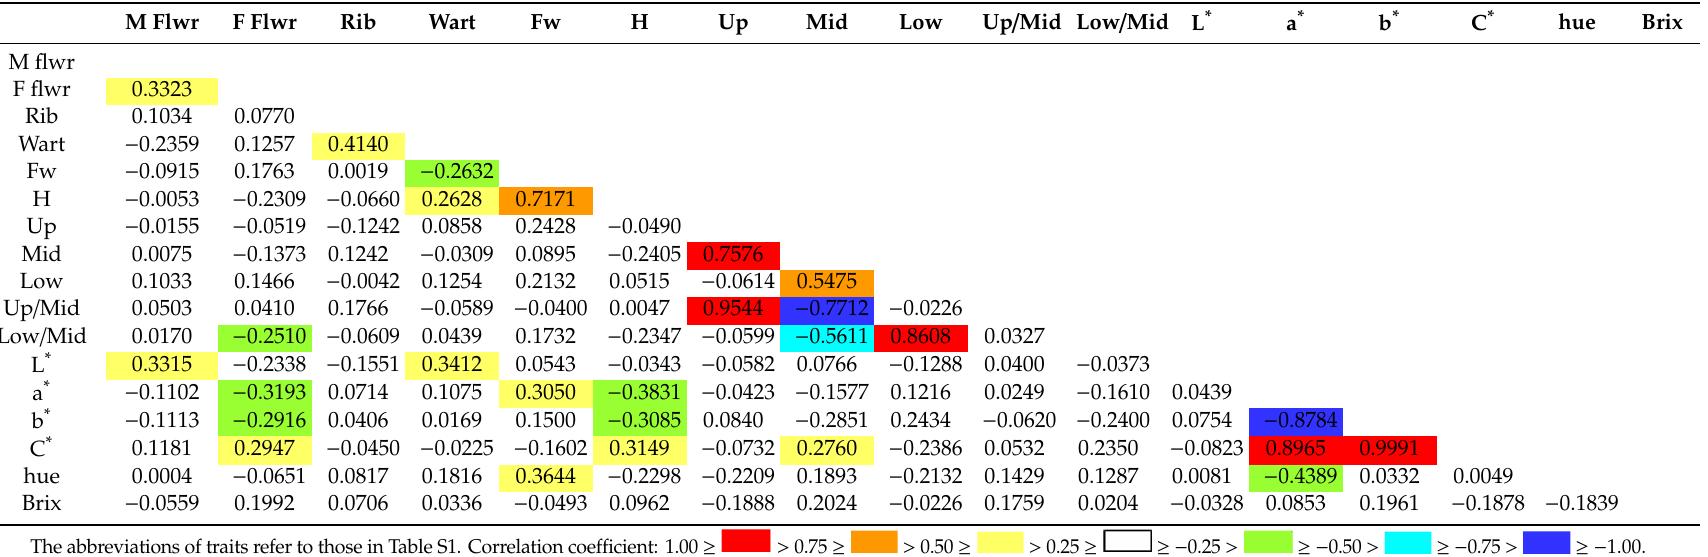
The abbreviations of traits refer to those in Table S1. Correlation coefficient: 1.00